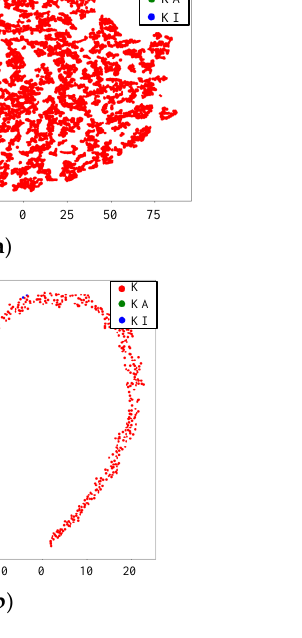
Figure 5. Visualization results with ( a ) IFKNMD-CNN and ( b ) IFKNMD-1DCNN.